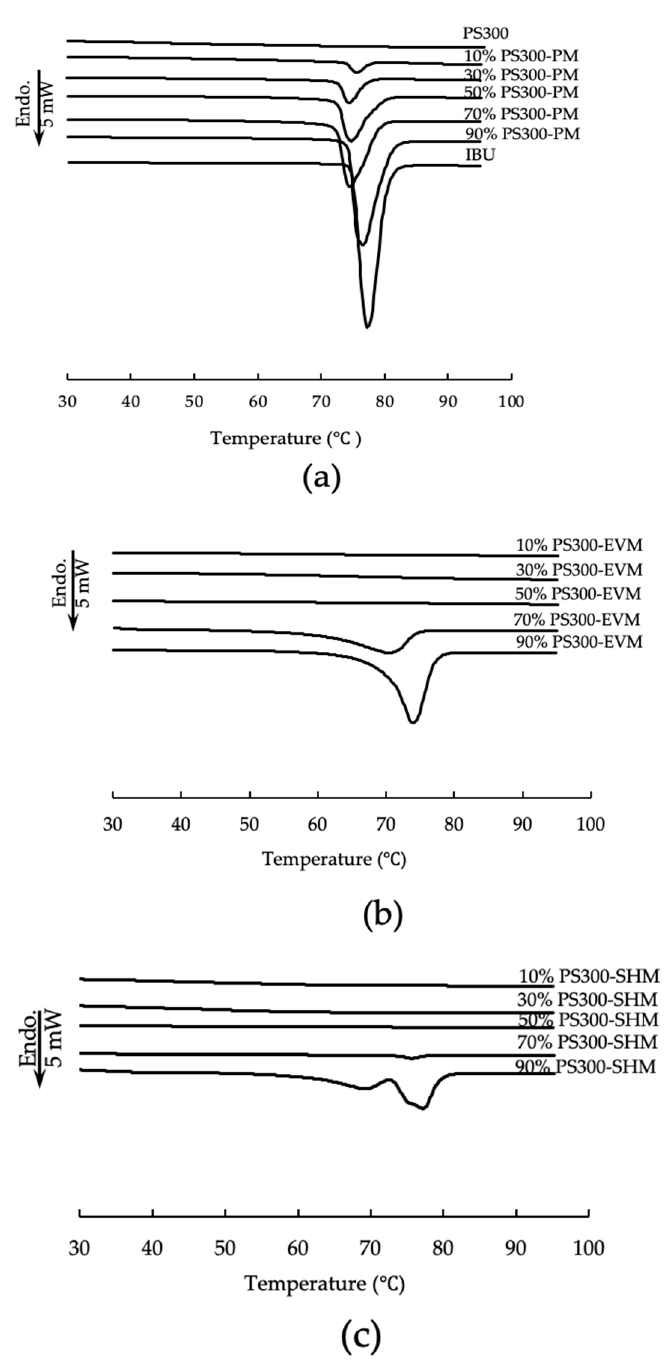
Figure 3. DSC curves of various samples. ( a ) IBU, PS300, and PMs of various mixing ratios; ( b ) EVMs of various mixing ratios; ( c ) SHMs of various mixing ratios.